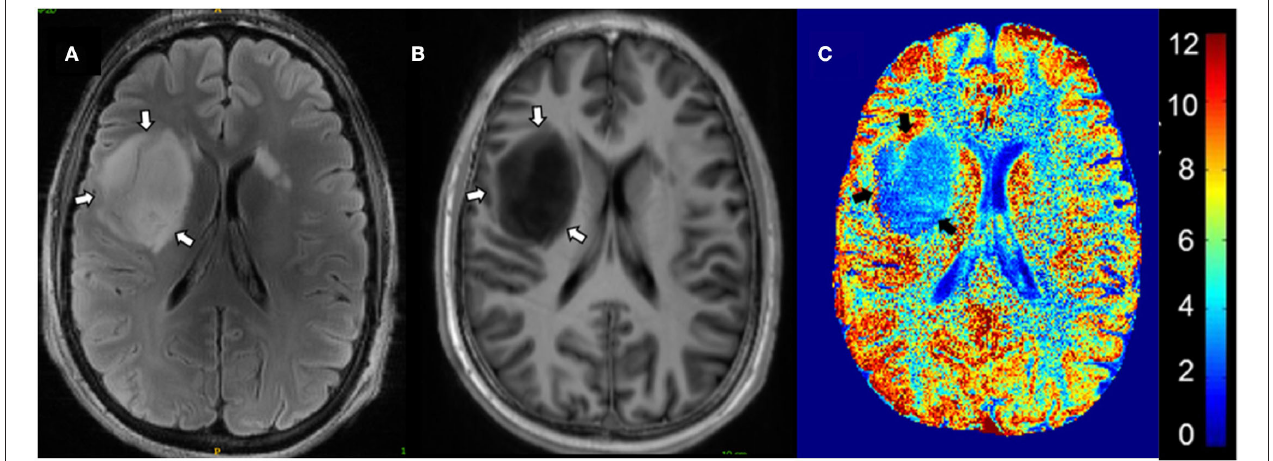
FIGURE 4 | Glutamate-CEST imaging of a diffuse astrocytoma. (A) 3T FLAIR with tumors identified by white arrows. (B) 7T FLAIR with tumors identified by white arrows. (C) Glutamate-CEST contrast map with tumors identified by black arrows and CEST contrast gradient on the right. Figure used with permission from Neal et al., 2019 (